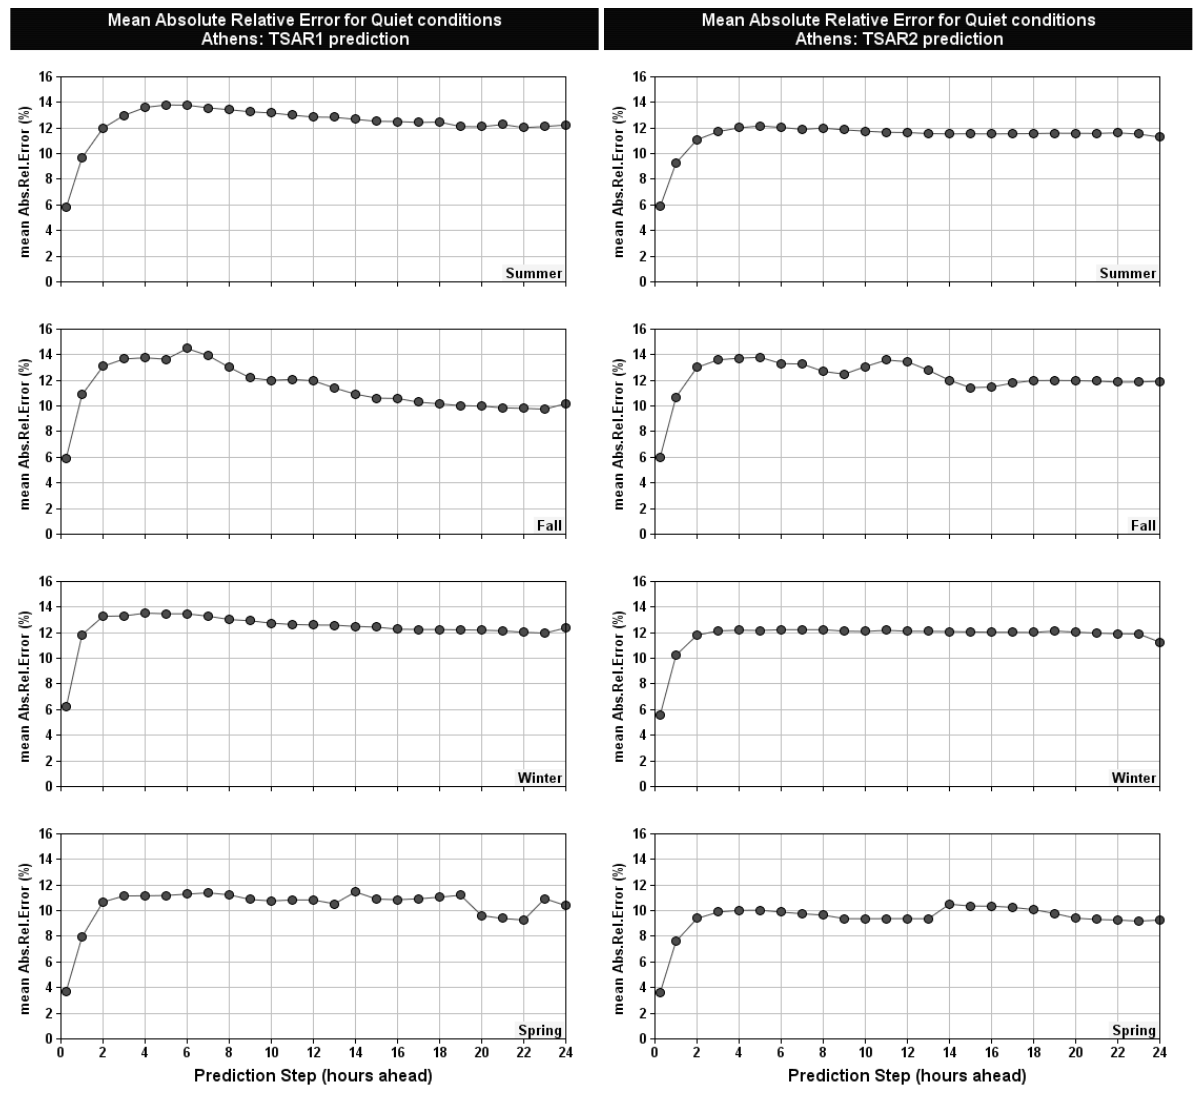
Fig. 9. The mean absolute relative error estimates for Athens as a function of the prediction step (1–24h ahead) for each